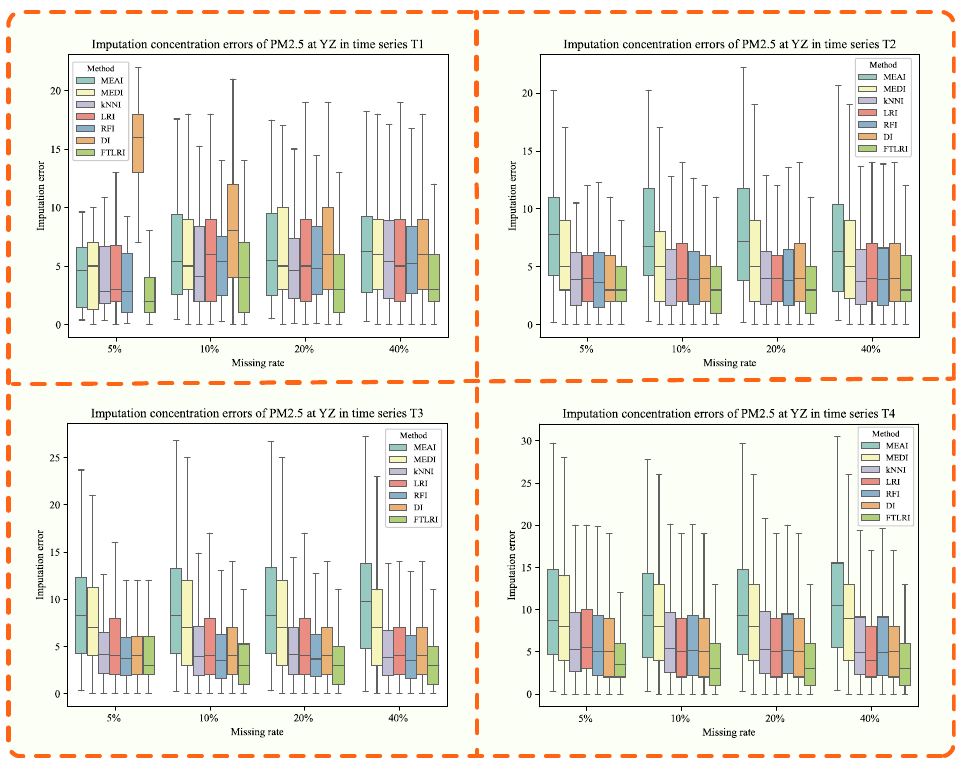
Figure 8. Imputation concentration errors of PM 2.5 generated by MEAI, MEDI, kNNI, LRI, RFI, DI, FTLRI at YZ in different time series.